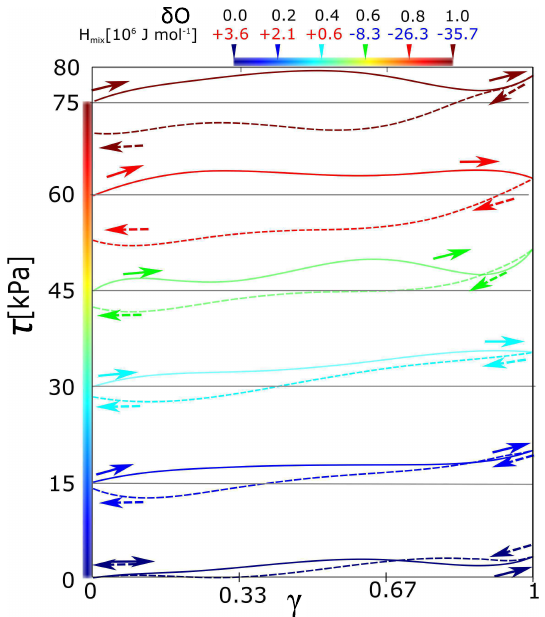
Figure 2. Stress-strain curves of forward-reverse shear deformations for networks with different partial charges. Charges on oxygen from PEG were δ O = 0.0 to –1.0. Solid lines are forward deformation, dash lines are reverse deformation. All curves show the hysteresis. The curves for δ O = from –0.2 to –1.0 were shifted equidistantly along the y -axis for better visibility. (Upper legend H mix is a mixing enthalpy of the individual